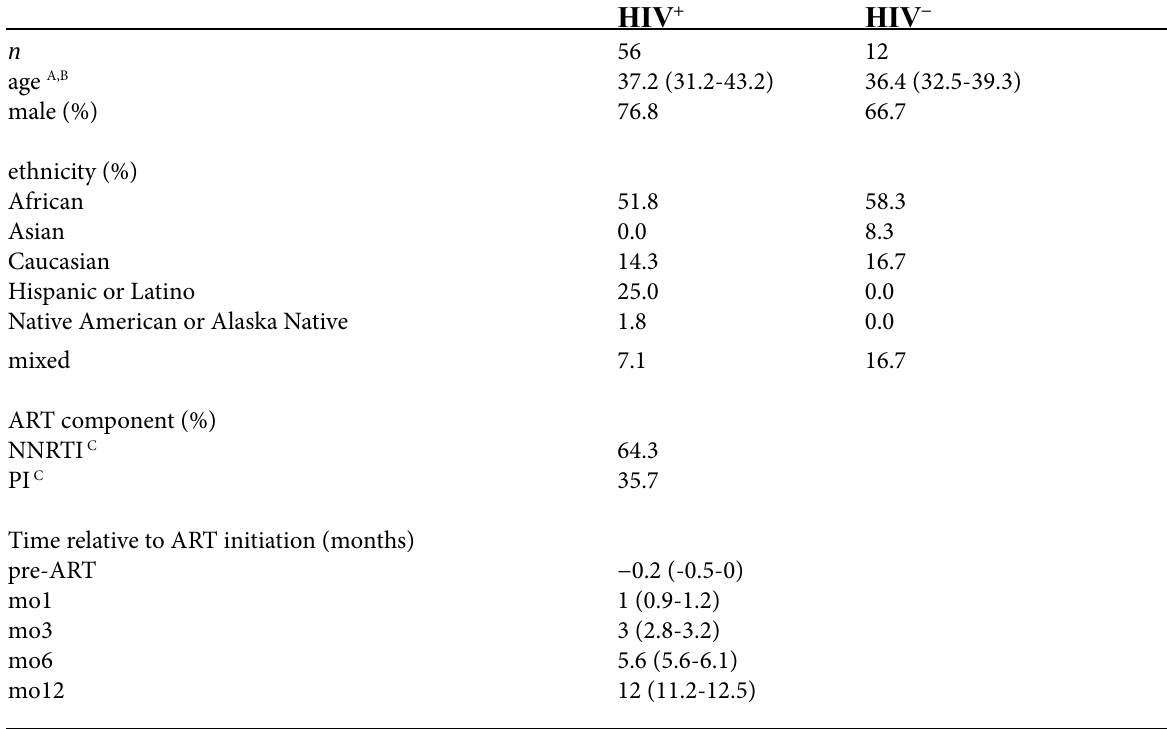
TABLE 1. PATIENT COHORT CHARACTERISTICS